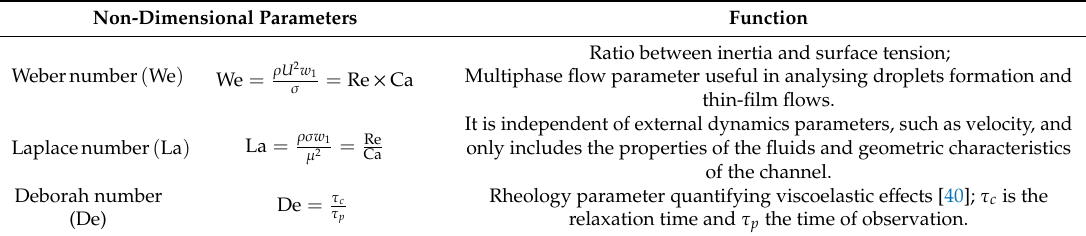
Table 5. Dimensionless numbers sometimes used when working with two-phase